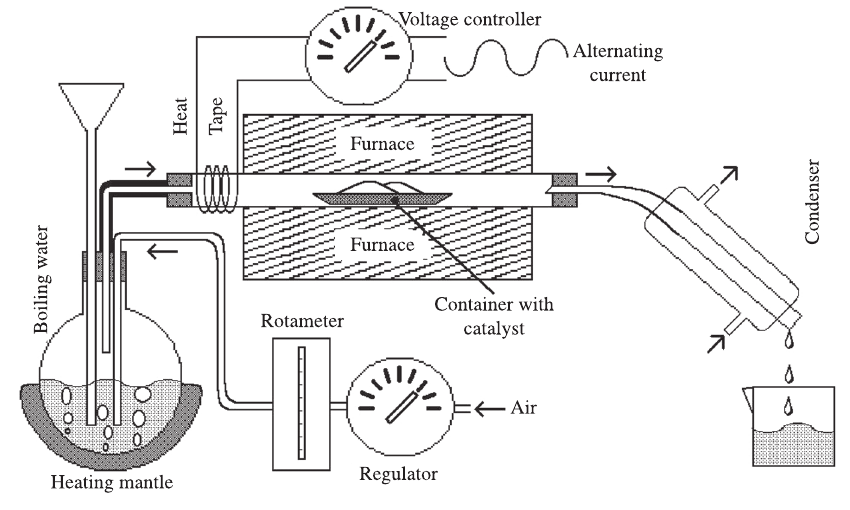
Figure 1. Schematic of apparatus for hydrothermal treatment.